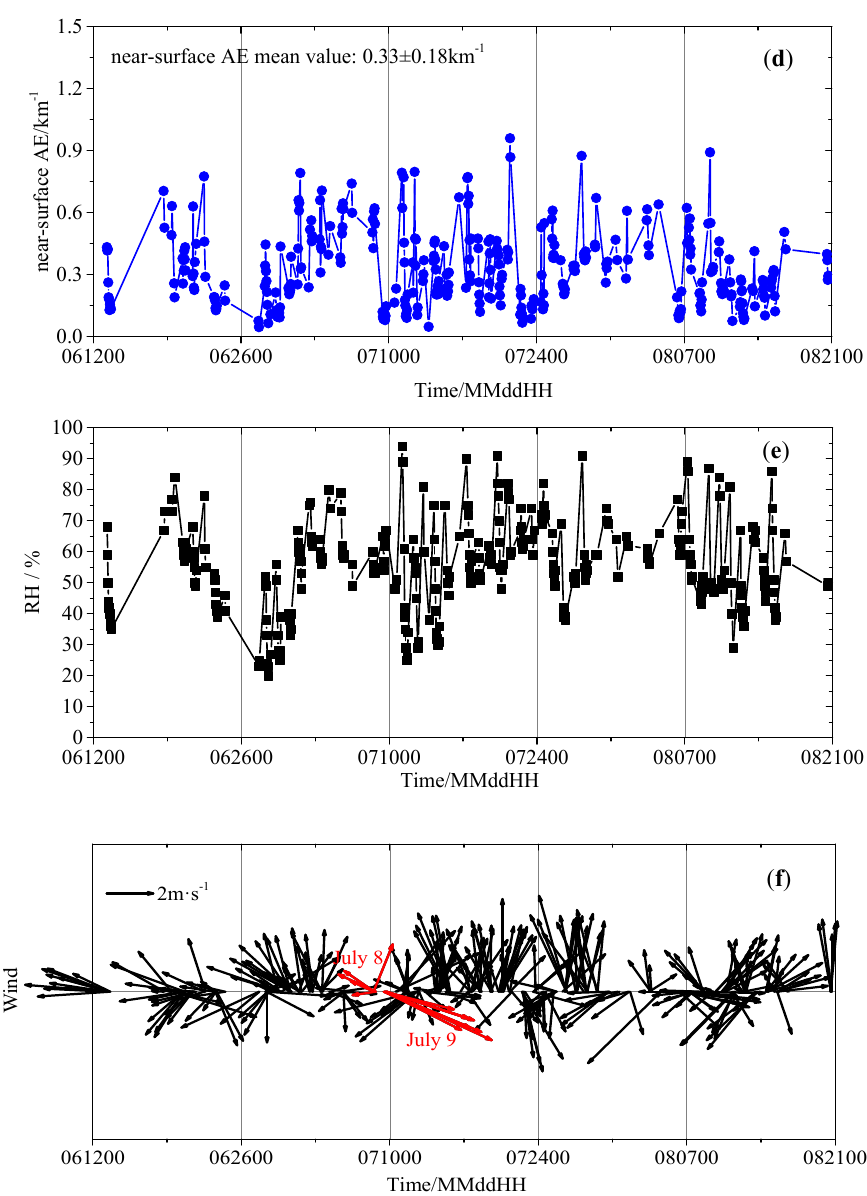
Figure 3. Time series of the qualified hourly average multi-axis differential optical absorption spectroscopy (MAX-DOAS) results and meteorological variables: ( a ) aerosol extinction (AE) profiles from MAX-DOAS for the experimental period; ( b ) enlarged AE profiles for the period marked by the black rectangle in panel (a); ( c ) aerosol optical depth (AOD) and ( d ) near-surface AE from MAX-DOAS for the experimental period; ( e ) in situ surface relative humidity (RH) and ( f ) in situ surface wind direction (WD) and wind speed (WS) with the scale of WS = 2 m·s − 1 for the experimental period. The numbers, given in the Figure 3c,d denote the means ± 1 standard deviation of AODs (dimensionless quantity) and AEs (Unit: km − 1 ) during the observational period. The red arrows in Figure 3f present the wind on 8 July and 9 July, respectively.